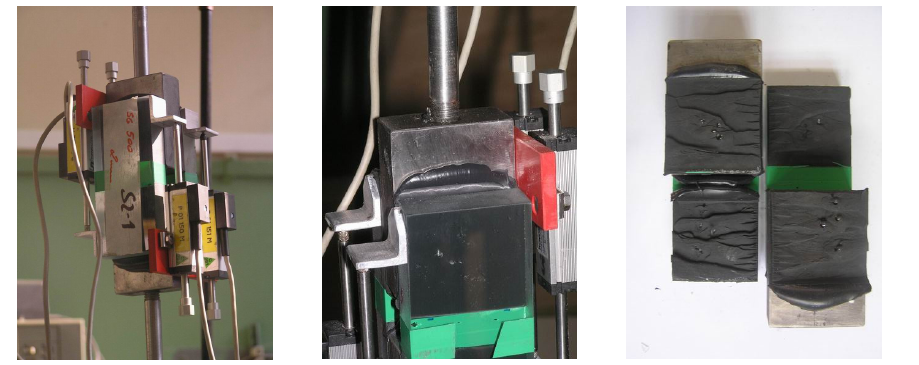
Figure 5a, b and c : Shear tests, details.